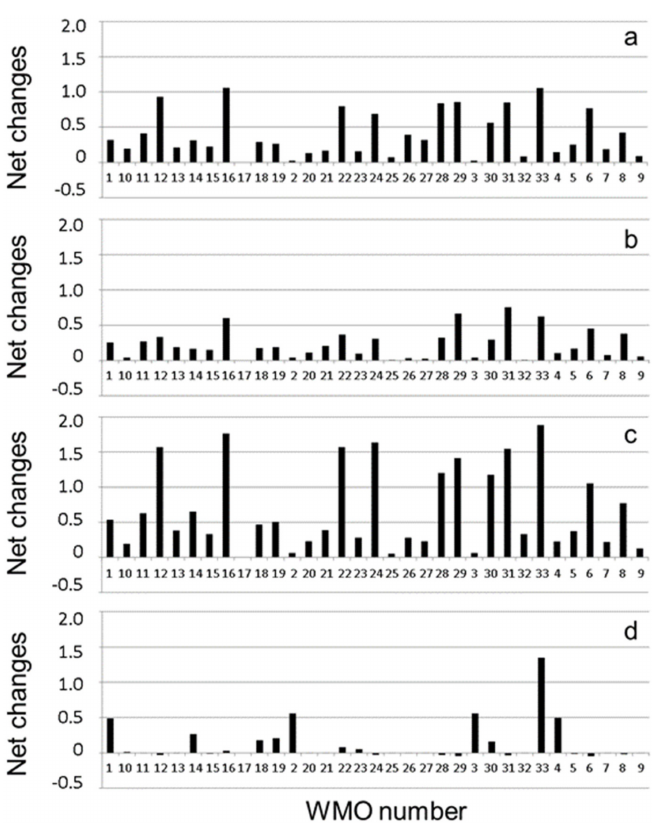
Figure 2. Impact assessment of WMOs on the Tordera river basin challenges included in the Fuzzy Cognitive Map (FCM) as factors: impacts on ( a ) ‘water quality’, ( b ) ‘water quantity’, ( c ) ‘health of water ecosystems’, and ( d ) ‘health of forests’. The bars represent net changes from the baseline situation and show how each WMO (1 to 33) affects the river basin dynamics of the FCM model. Positive values correspond to the improvement of the challenge and negative values correspond to